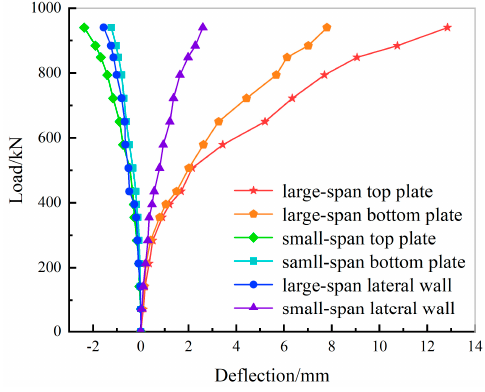
Figure 10. Load-midspan deflection curves.